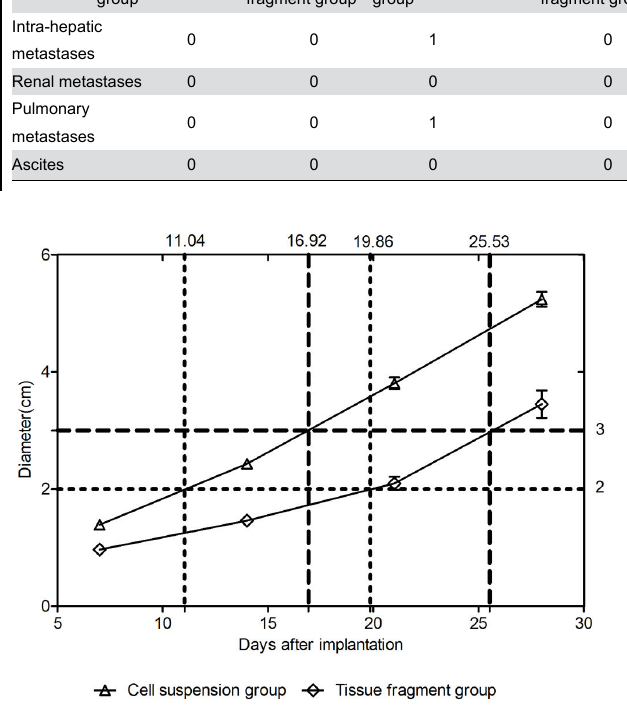
Figure 3. Time-tumor diameter curves of the cell suspension group and the tissue fragment group after implantation. Six reference lines were used to estimate the growth time of tumor diameter corresponding to 2 cm and 3 cm.